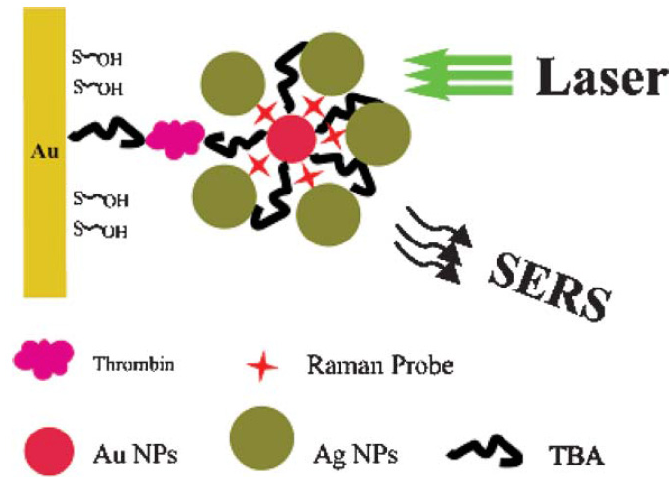
Figure 1. Schematic illustration of the fabrication process of a surface-enhanced Raman scattering (SERS) biosensor for protein recognition. AuNPs with a diameter of around 13 nm labeled with antibody and the Raman probe molecule were used as immuno-gold colloids, which were crosslinked onto the solid chip during the process of immunoassay detection. After the Ag colloids’ deposition, the SERS signal of the Raman probe was obtained [56]. (Reproduced with permission from Wang et al ., published by Royal Society of Chemistry,